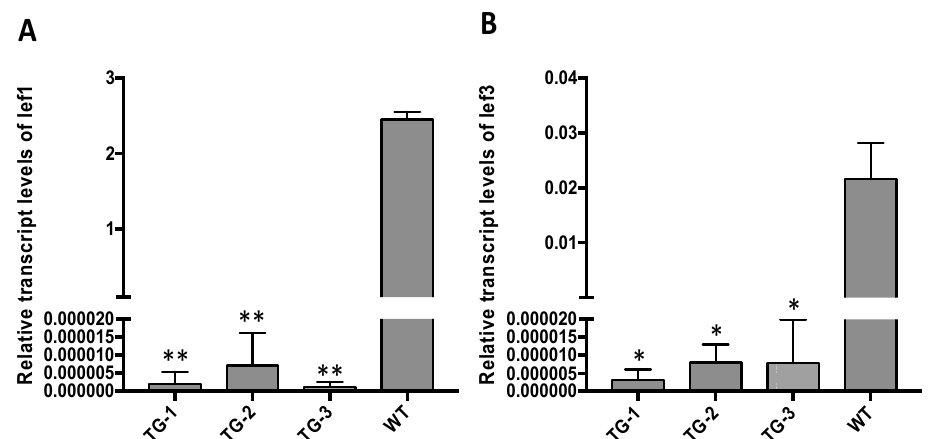
Figure 4. Expression levels of BmNPV lef-1 and lef-3 mRNAs in transgenic and wild-type silkworms treated with 10 6 OBs/larva at 72 hpi. The relative transcript levels of ( A ) lef-1 and ( B ) lef-3 are shown. Data represent the mean ± SEM. * p < 0.05, ** p < 0.01, by one-way ANOVA. 3.4. The Antivirus Efficiency of the Baculovirus-Inducing and Targeting CRISPR/Cas9 System Is High To more accurately evaluate the antiviral efficiency of the TG silkworm lines, we in- vestigated the relative number of DNA copies of BmNPV genes to monitor viral prolifer- ation in TG and WT silkworms. The genes ie-1 , gp64 , and p10 , which are present in single copies in the BmNPV genome, were selected as indicators in a qPCR analysis for relative